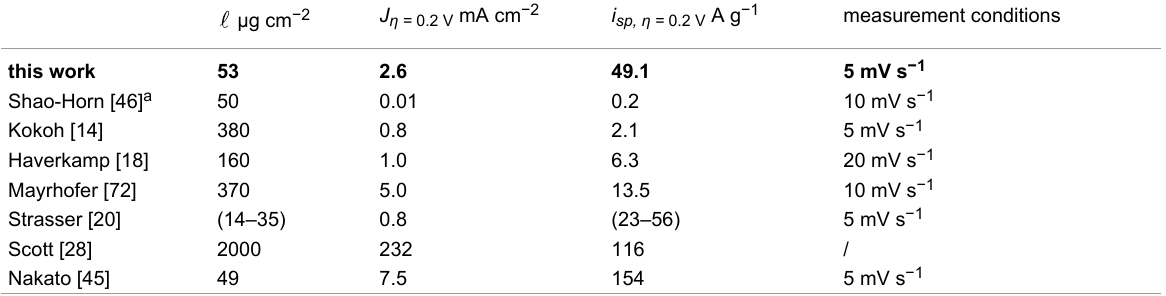
Table 1: Comparison of loadings , current densities J , and activities (specific currents i sp = J / ) between selected literature precedents and the cur- rent results. At an overpotential of 0.2 V, our system reaches current densities comparable to the highest of the literature with Ru catalyst loadings comparable to the lowest in the literature. The activity is correspondingly maximal.